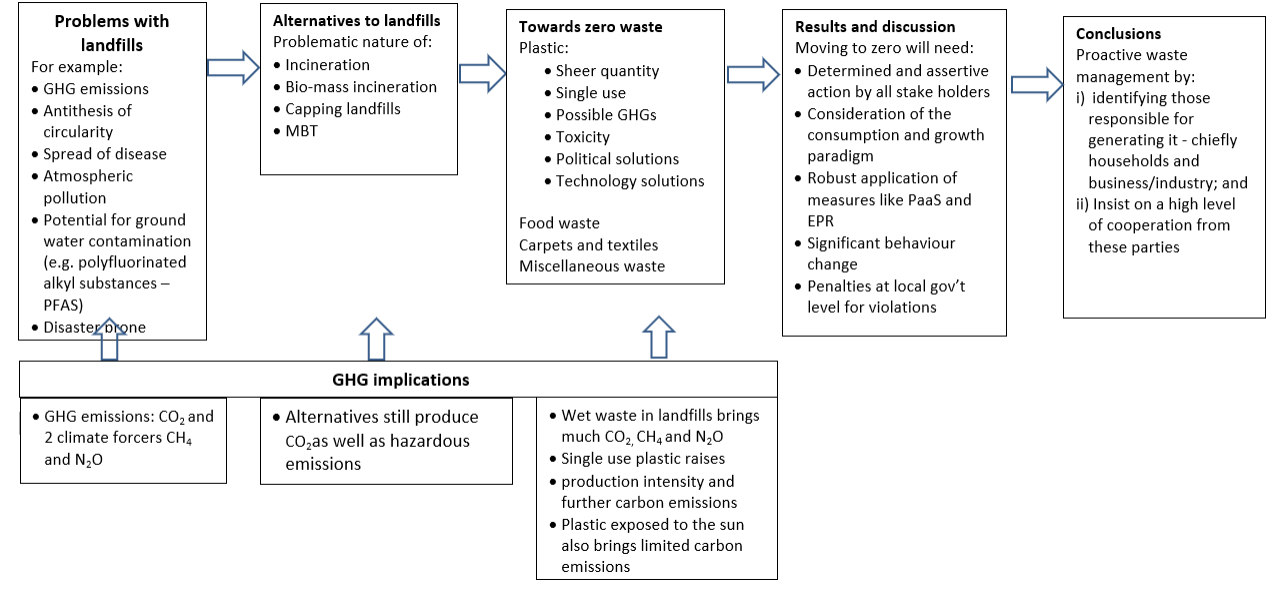
Figure 2. Landfills, GHGs and the focus and structure of the research.